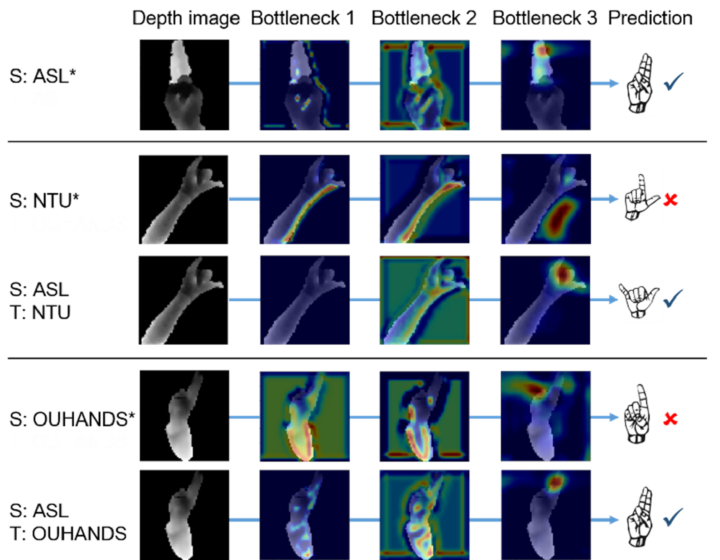
Figure 9. Visualization of the learned features when applying transfer learning to RFaNet, where S and T represent the source and target dataset, respectively. Each row indicates the feature maps of three bottlenecks of RFaNet. The asterisk indicates that RFaNet was trained using only the source data and evaluated on the source data. The third and fifth rows indicate that RFaNet was pre- trained with the source data, fine-tuned with the target data, and evaluated on the target data. This study considered the ASL dataset as the source data due to the sufficiently large training data and considered the OUHANDS and NTU datasets as the target data due to the relatively small amount of training data. The icons in the prediction column were reproduced from [57].